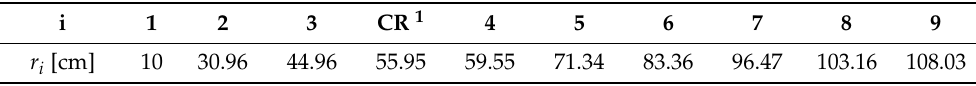
Table 4. Average positions of radial burnable zones.